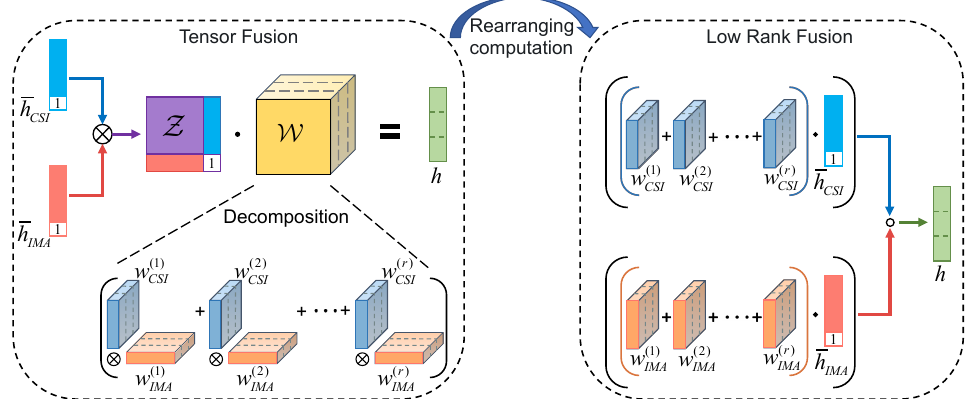
Figure 5. Derivation of low-rank fusion method. Left: The introduction and approximate decomposi- tion of Tensor Fusion. Right: Low-Rank Fusion based on signal-specific low-rank